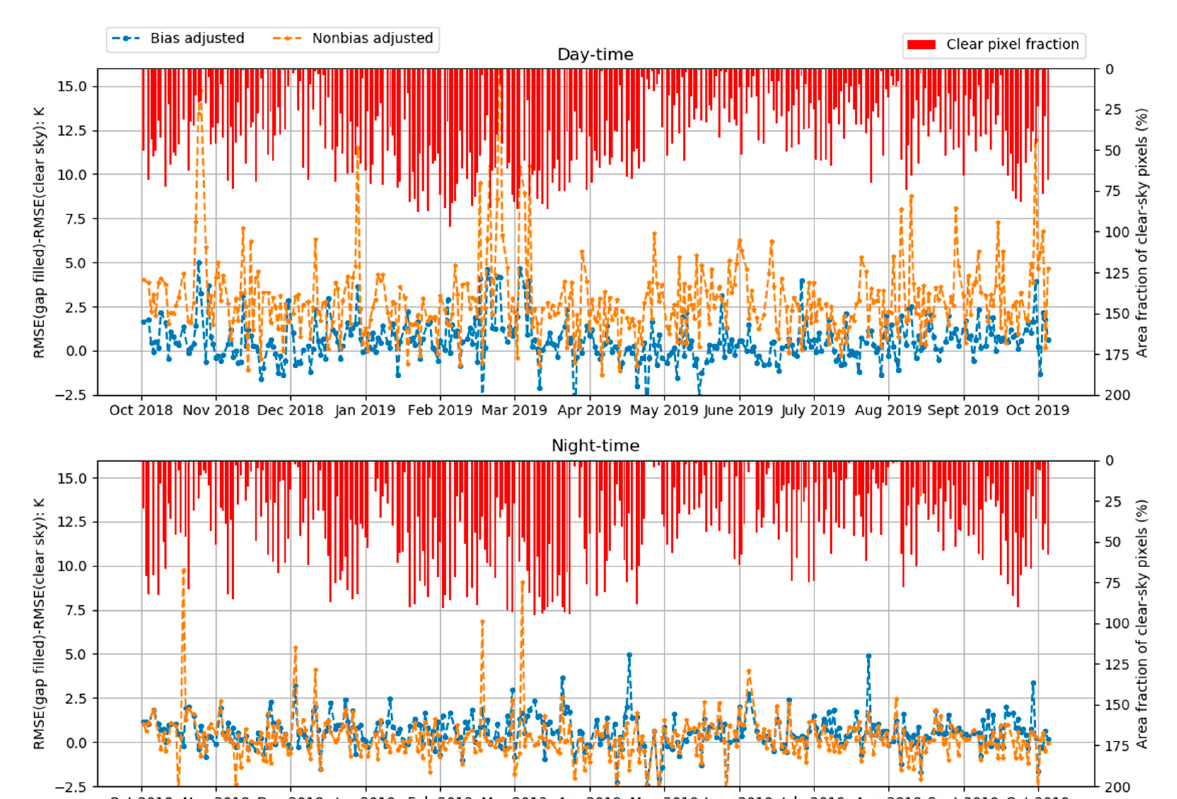
Figure 9. RMSE of MODIS Clear, MODIS STDF, and MODIS PMBC against SEVIRI LST for different land cover types in the day ( top ) and in the night ( bottom ). Numbers in the brackets denote pixel numbers of that specific land cover type.